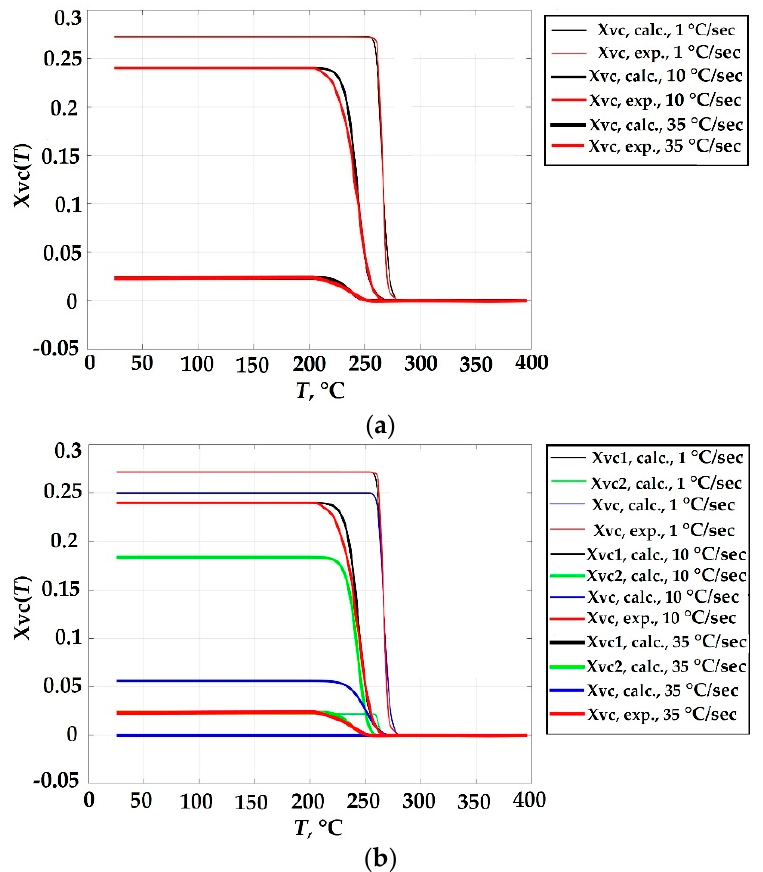
Figure 2. Temperature dependence of the degree of crystallization of PEEK during cooling at different speeds: ( a ) without detailing the mechanisms of crystal nucleation; ( b ) with detailing. Black, green, and blue lines show calculations; red ones show experiments [7].